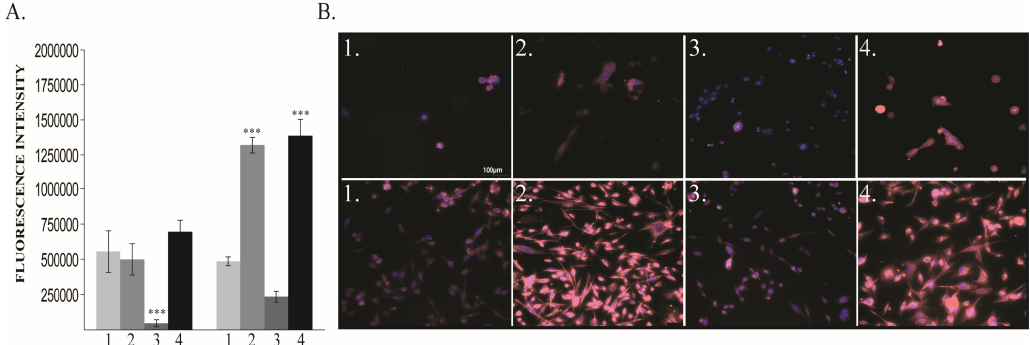
Figure 4. Vimentin protein expression. ( A ) Protein quantification: left MCF10A, right MDA-MB-231 ( B ) Immunofluorescence pictures: upper panel MCF10A, lower panel MDA-MB-231; 1—21% O 2 , 2—40% O 2 , 3—60% O 2 , 4—80% O 2 . *** p < 0.0005.